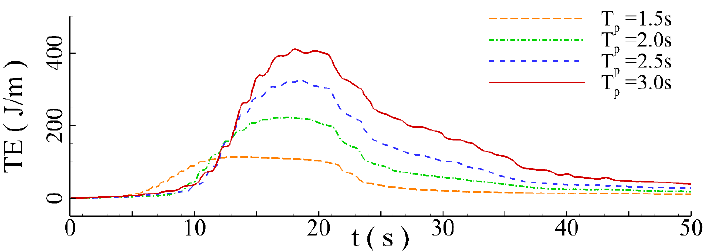
Figure 31. Comparisons of the total wave energies in the whole computational domain under different peak wave periods.